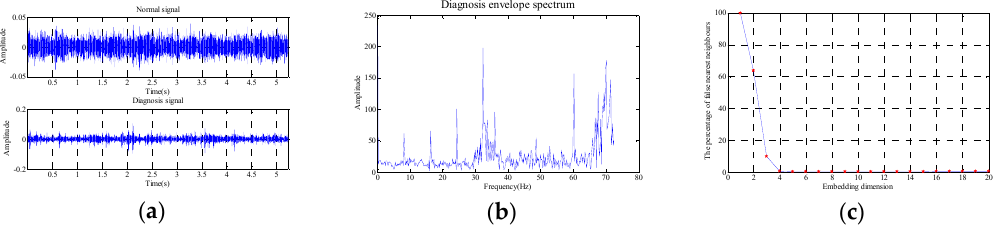
Figure 16. Outer race fault ( a ) time domain waveform, ( b ) envelope spectrum ( c ) embedded dimension.